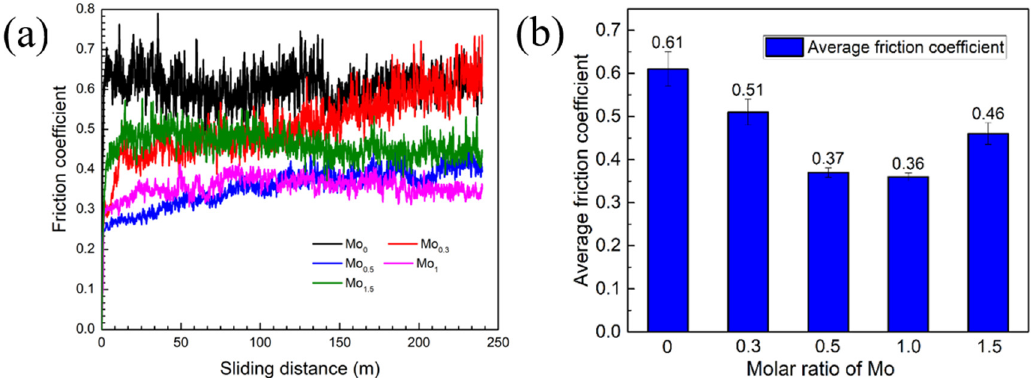
Figure 8. ( a ) Evolution of friction coefficients with the sliding distance for the Mo x HEAs in wear process after 240 m sliding under 20 N at a speed of 0.1 m/s, ( b ) the average friction coefficient of Mo x alloys.